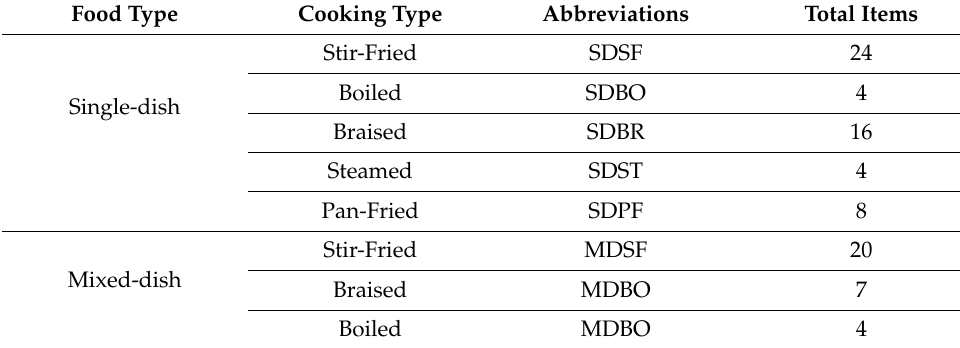
Table 2. Type of dish information summary.